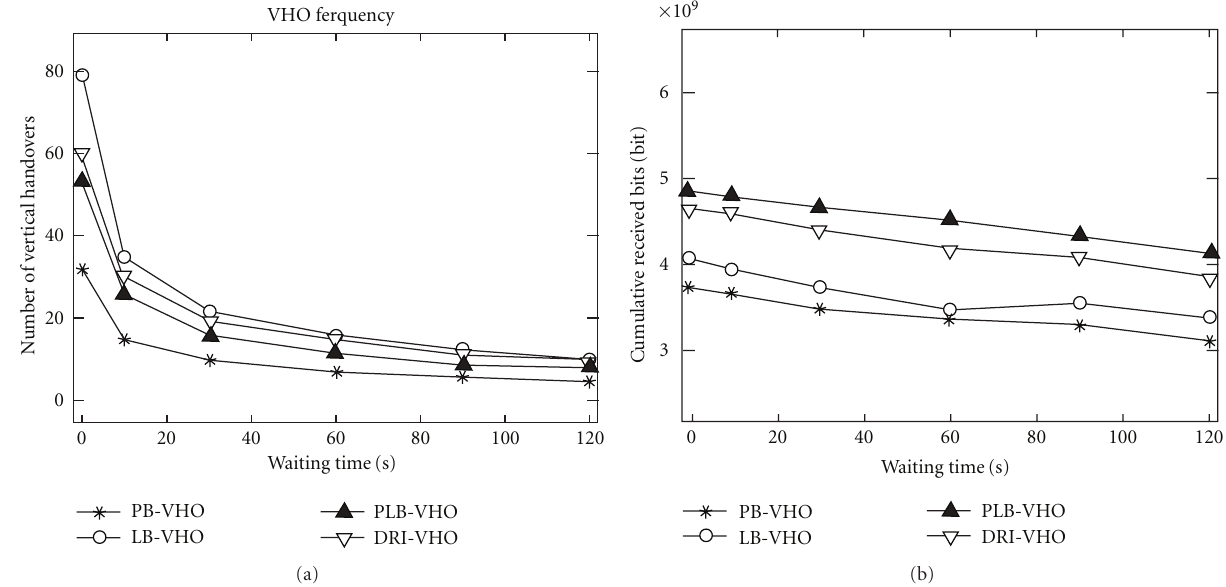
Figure 5: (a) Average of number of vertical handover occurrences for PB, LB, DRI, and PLB. The handovers are performed by a MT during its path, for di ff erent values of waiting time constraints.Performances have been obtained over 100 simulationscenarios. (b) Average of CRBs performance for PB, LB, DRI, and PLB-VHO versus di ff erent values of waiting time parameter. Performances have been obtained over 100 simulation scenarios.